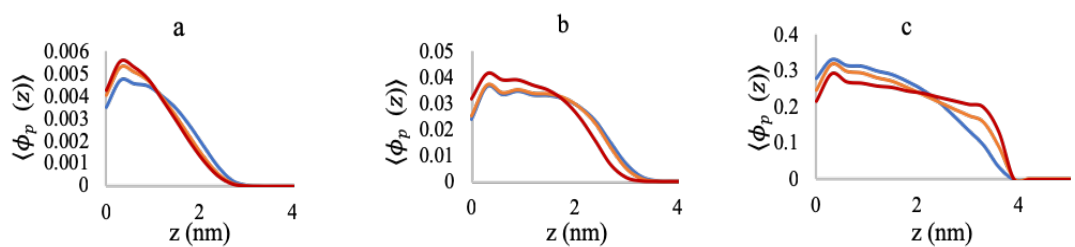
Figure 3. Total polymer volume fraction profiles as a function of distance from the grafting surface at ( a ) 0.005 chains/nm 2 , ( b ) 0.05 chains/nm 2 , and ( c ) 0.5 chains/nm 2 . Blue lines correspond to 3 mM MgCl 2 , yellow lines to 50 mM MgCl 2 , and red lines to 180 mM MgCl 2 .